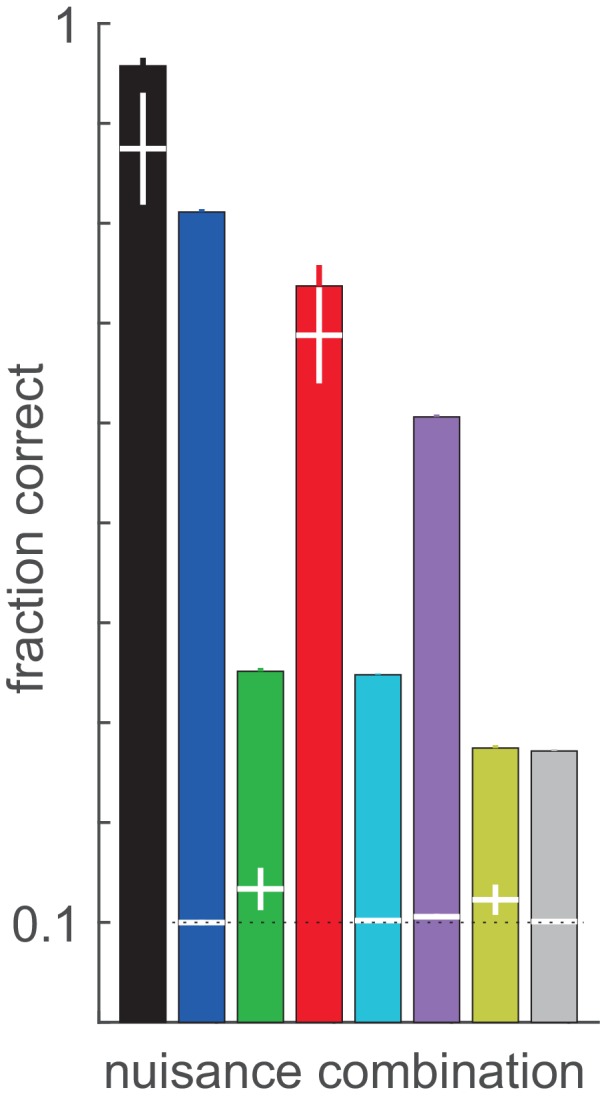
Variance in decoding performance as a result of variations in receptive field parameters of model neurons.Randomness was introduced by resampling the positions and phases of the Gabor filters that characterise the receptive fields of the model neurons. Means (bars) and 2 s.D. (error bars) are calculated from 25 random settings of the population. Sensitivity of the optimal performance of firing rate (filled bars) and membrane potential decoders (white horizontal lines on the bars) to variations in encoding population parameters for different nuisance parameter combinations. All of the membrane potential decoders where nuisance parameters are present (white lines on coloured bars) are significantly lower than that of the no-nuisace membrane potential decoder (white line on black bar), unpaired t-test: p=1.5e-33, t[22.1]=−132.5; p=4.0e-39, t[27.7]=−119.3; p=5.0e-27, t[43.3]=−24.5; p=1.9e-33, t[22]=−132.3; p=1.8e-33, t[22.1]=−131.5; p=2.2e-36, t[25]=−124.7; p=1.8e-33, t[22]=−132.4 for the seven bars, respectively. Firing rate decoders (coloured bars) were consistently outperforming membrane potential decoders for all conditions except for the case where contrast was the only nuisance parameter, consistent with the fact that contrast introduces variations that do not directly affect linear decoding boundaries (unpaired t-test: p=1.9e-33, t[22]=132.6; p=0.58, t[24]=−0.6; p=3.3e-14, t[24]=15.8; p=1.1e-33, t[23]=120.0; p=1.6e-12, t[24]=13.2; p=3.9e-17, t[24]=21.3; p=1.0e-13, t[24]=15.1; p=5.8e-06, t[23]=5.8543 for the eight conditions, respectively). Colours match those at Figure 4. Notice that the variance of optimal performance of the FR decoder is almost negligible, except for the no nuisance (black) and contrast nuisance (red) cases, where variance of membrane potential decoder performances are also high.